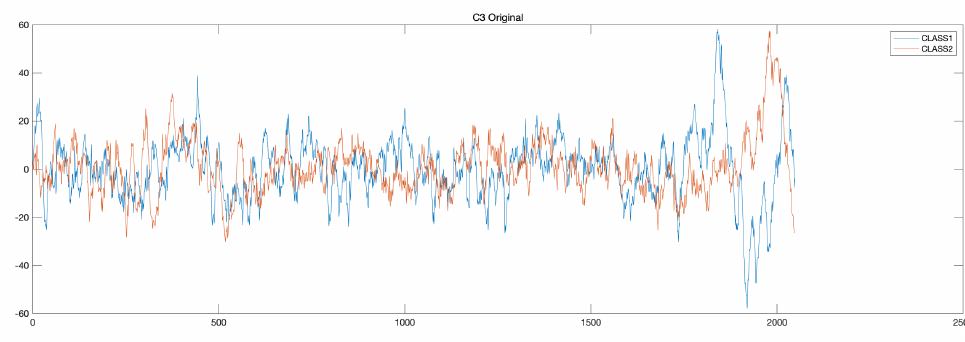
Figure 3. Motor imagery EEG signal of C3 of two classes.